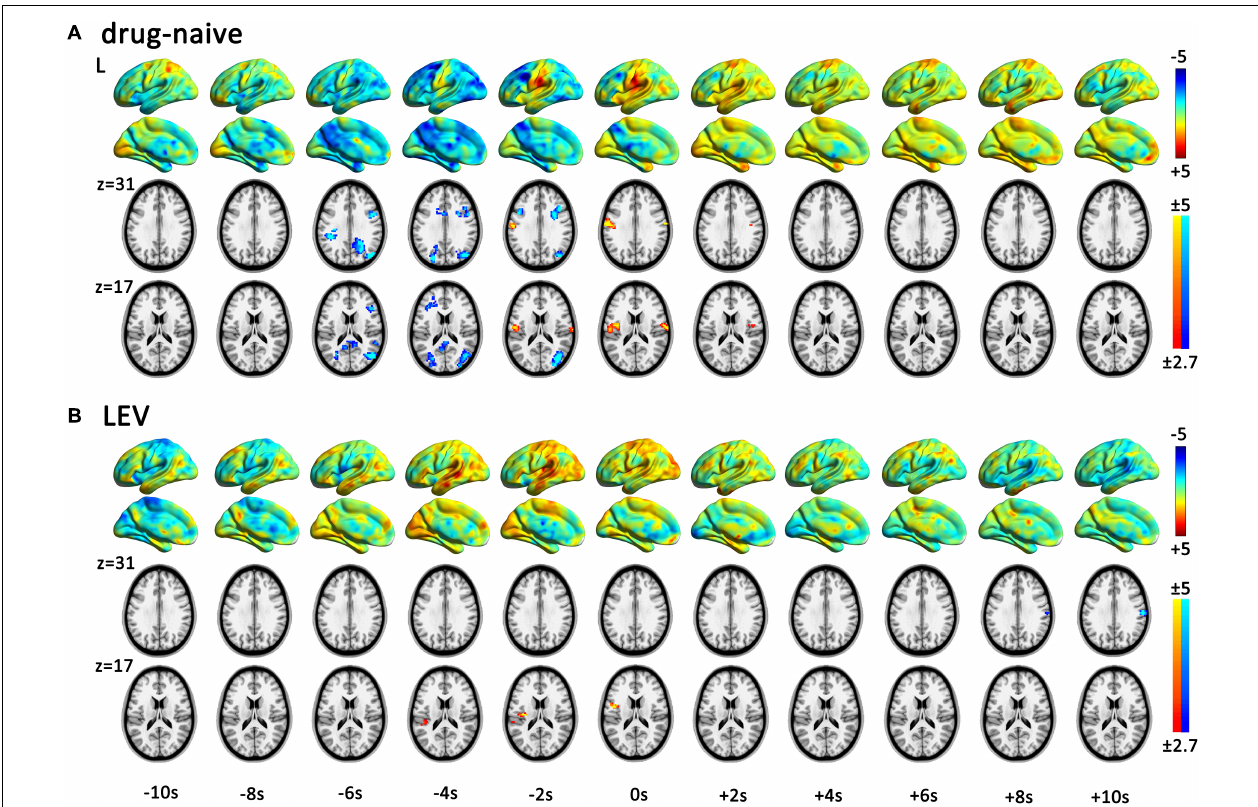
FIGURE 2 | Spatial patterns of dynamic CTS-associated activation/deactivation in the drug-naive and LEV-medicated patients. The horizontal axis represented start time of the sequential HRFs. One-sample t -test within each group was performed in each time point in sequential hemodynamic response functions (HRF) analysis (time point -10 to 10 s) for drug-naive and levetiracetam (LEV)-medicated patients. Render maps with p = 1 in the left brain show the consecutively altered dynamic BOLD activity pattern. Slices maps with p < 0.01 (voxel-level p < 0.01, and cluster-level p < 0.05 with GRF correction) show significant activation and deactivation regions in each time point. Both the groups presented centrotemporal spikes (CTS)-associated activation in the Rolandic cortex. Viewed from the dynamic activation/deactivation, (A) drug-naive patients show Rolandic cortex activation during period from -2 to +2 s and extra Rolandic cortices deactivation before CTS onset (-6 to -2 s). (B) LEV-medicated patients show left Rolandic cortex activation during period from -4 to 0 s followed by deactivation after +8 s. LEV, levetiracetam.